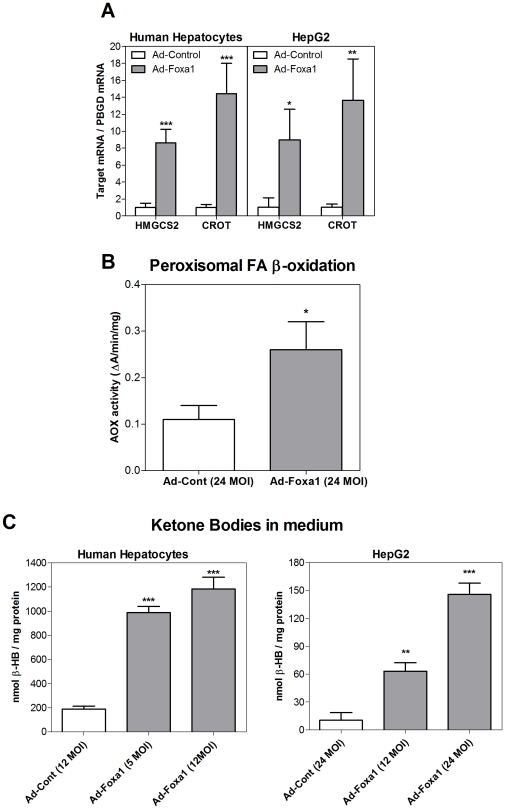
Foxa1 increases FA catabolism and KB synthesis.(A) Cultured cells were infected with Ad-Foxa1 or Ad-Control for 48 h, and the mRNA level of the mitochondrial 3-hydroxymethyl glutaryl coA synthase (HMGCS2, ketogenesis) and the peroxisomal carnitine O-octanoyltransferase (CROT, β-oxidation) were measured by real-time Q-RT-PCR. (B) HepG2 were infected with Ad-Foxa1 or Ad-Control and 48 h after infection ACOX activity was assayed spectrophotometrically in cell homogenates using palmitoyl-CoA as the substrate. Results were expressed as increments of absorbance at 502 nm (ΔA)/min/mg of protein. (C) Human hepatocytes and HepG2 cells were infected with Ad-Foxa1 for 24 h and were then exposed to 0.2 mM FA for an additional period lasting 24 h. The concentration of KB (β-HB, β-hydroxybutyrate) was determined in the culture medium with a specific kit. Data represent the mean±SD of 4–5 independent experiments. * p<0.05; ** p<0.01; *** p<0.001.